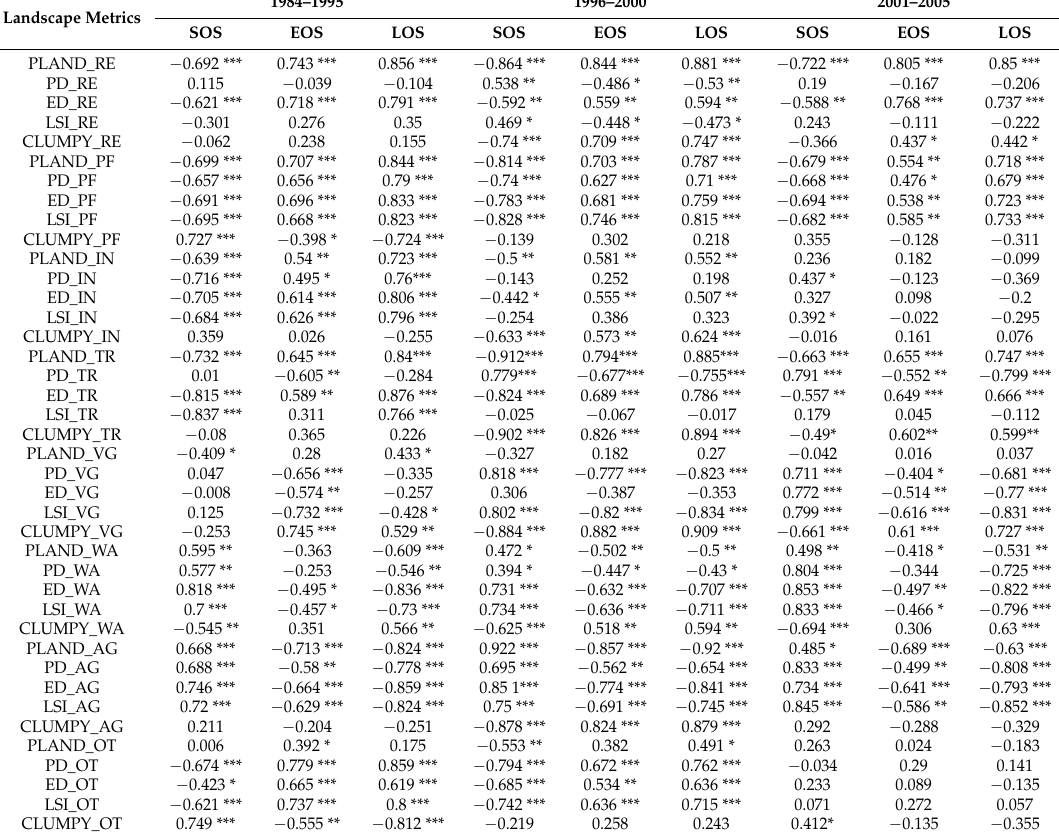
Table 7. Pearson correlation coefficients between SOS, EOS, and LOS of urban vegetation and class level landscape metrics for time intervals 1984–1995, 1996–2000, and 2001–2005. The last two letters after each landscape metric signify the LCLU type as defined in Section